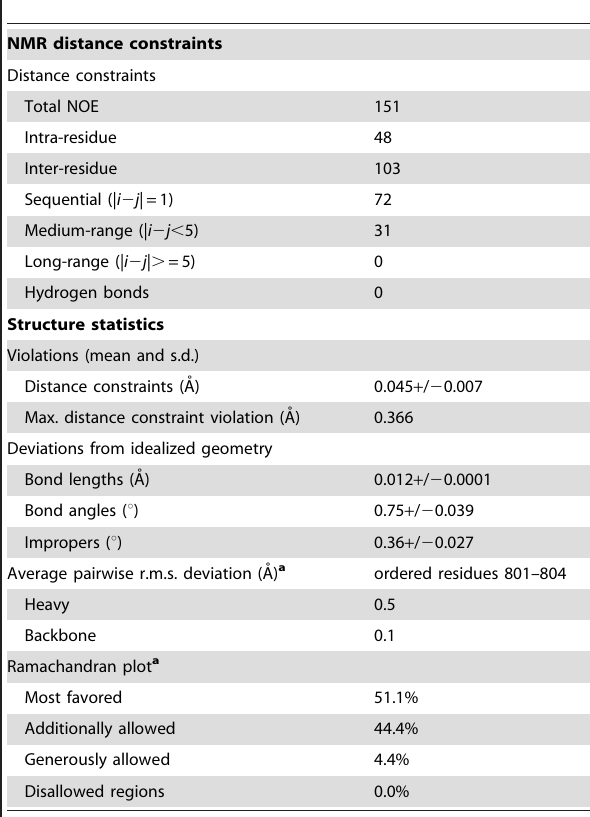
Table 1. Structural statistics for the 15 final NMR structures of VpepB.